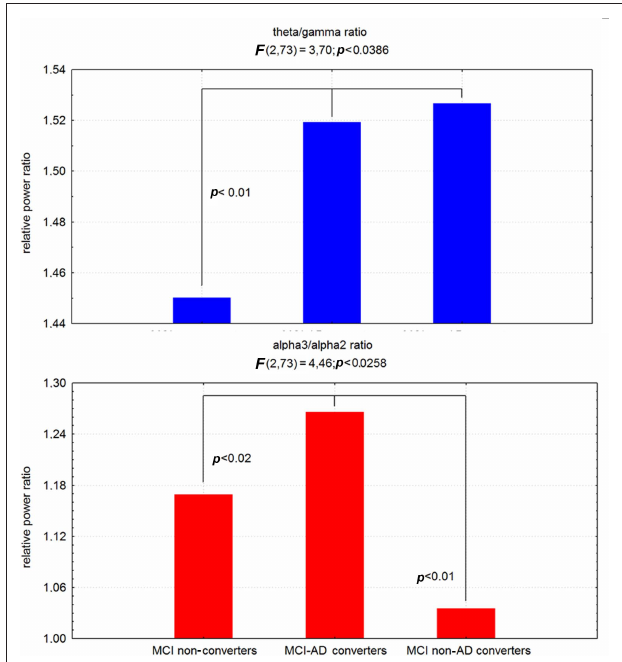
FiGurE 4 | ANOVA results of theta/gamma and alpha3/alpha2 relative power ratio. In the graph post hoc results are